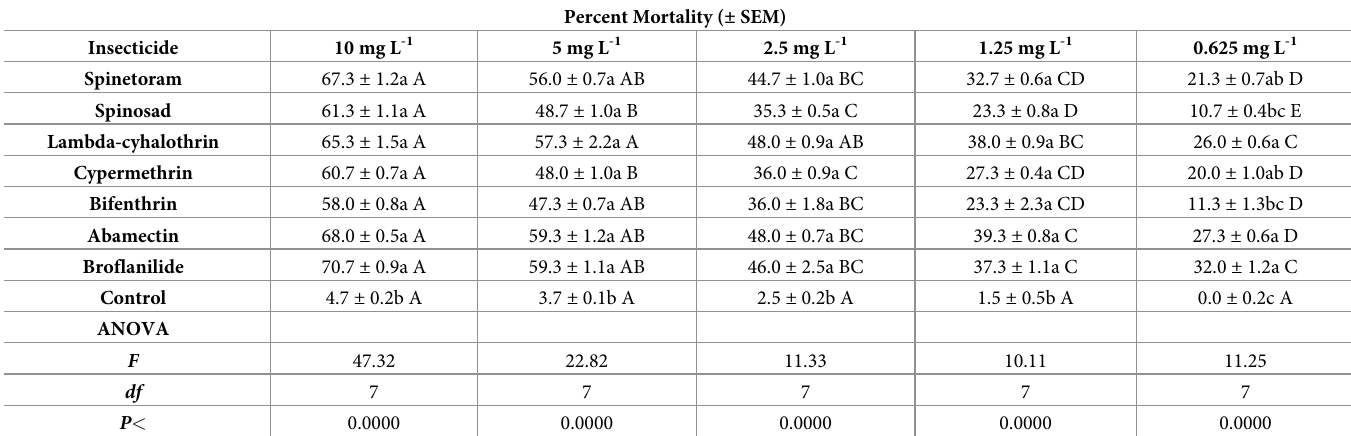
Table 2. Percent mortality of second instar S . frugiperda larvae to synthetic insecticides at 24 h post-treatment.